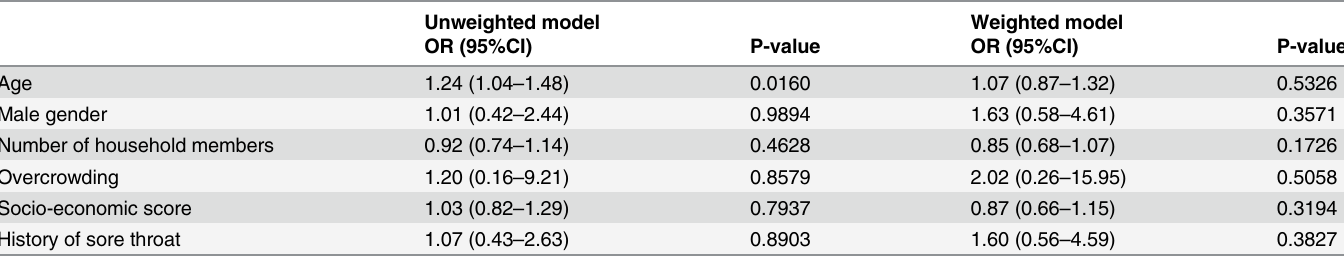
Table 4. Predictors of rheumatic heart